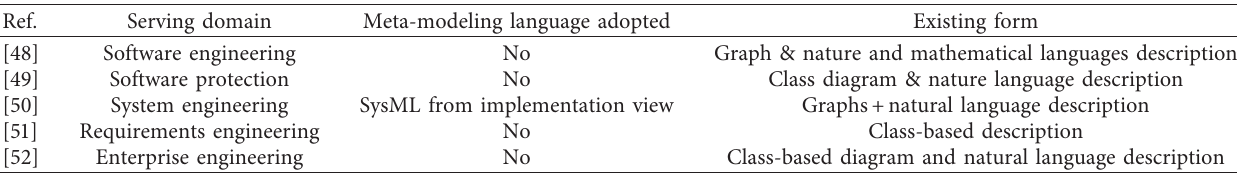
Table 13: Meta-models defined in practice.